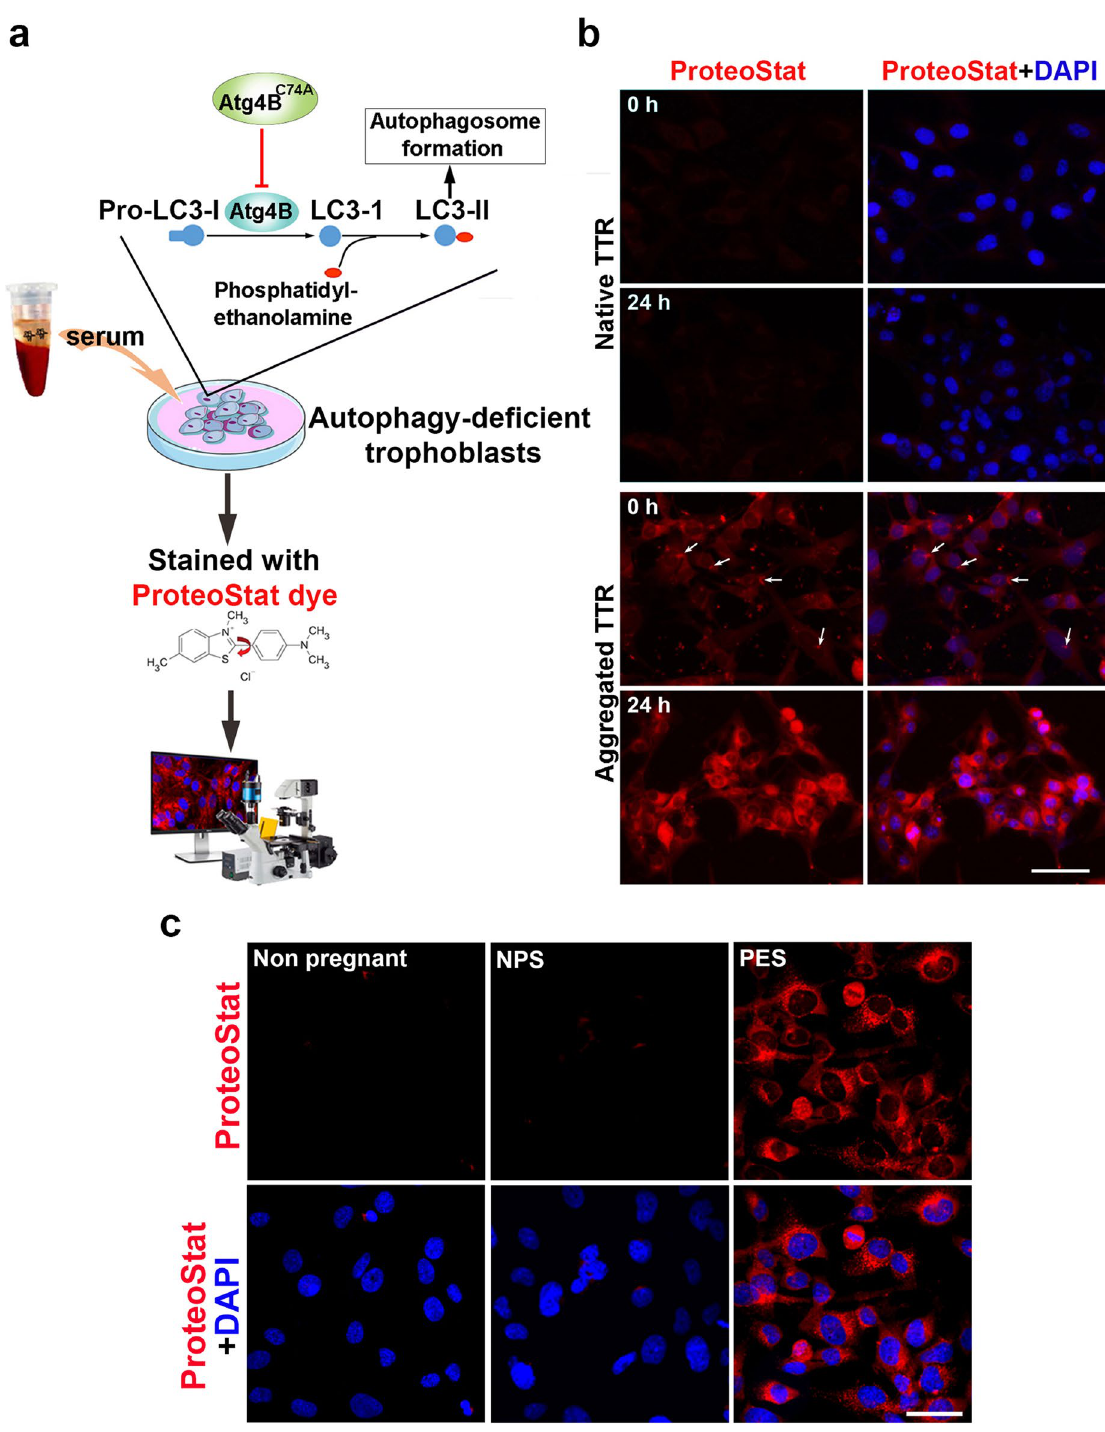
Figure 1. Validation of the protein aggregation assay. ( a ) Schematic diagram of the protocol. Autophagy- deficient trophoblast cells (ADTs) were incubated for various time periods with aggregate-containing sera, fixed and then stained with ProteoStat dye alone or in combination with immunostaining with specific protein antibodies. Red ProteoStat fluorescent signal was imaged with laser confocal microscope and then quantified. ( b ) Representative images for the internalization and accumulation of in vitro generated transthyretin (TTR) aggregates in ADTs. TTR aggregates were generated by incubation of recombinant human TTR in acetate buffer (see “Methods”). ADTs were treated with native TTR or aggregated TTR, fixed at 0 h or overnight after 20-min incubation on ice and then stained with ProteoStat dye (red). The nuclei were stained with DAPI (blue). Bar: 20 µm. ( c ) Incubation of sera from early onset preeclampsia (PES) not from non-pregnancy and normal pregnancy (NPS) results in accumulation of total protein aggregates in ADTs. Images are representatives of at least 3 independent experiments. The nuclei were stained with DAPI (blue). Bar: 50